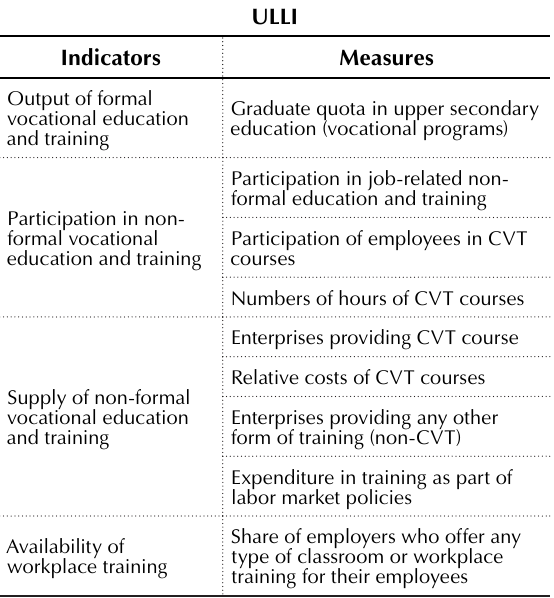
Table 3. The adapted dimension of learning to do Source: Developed by the authors.